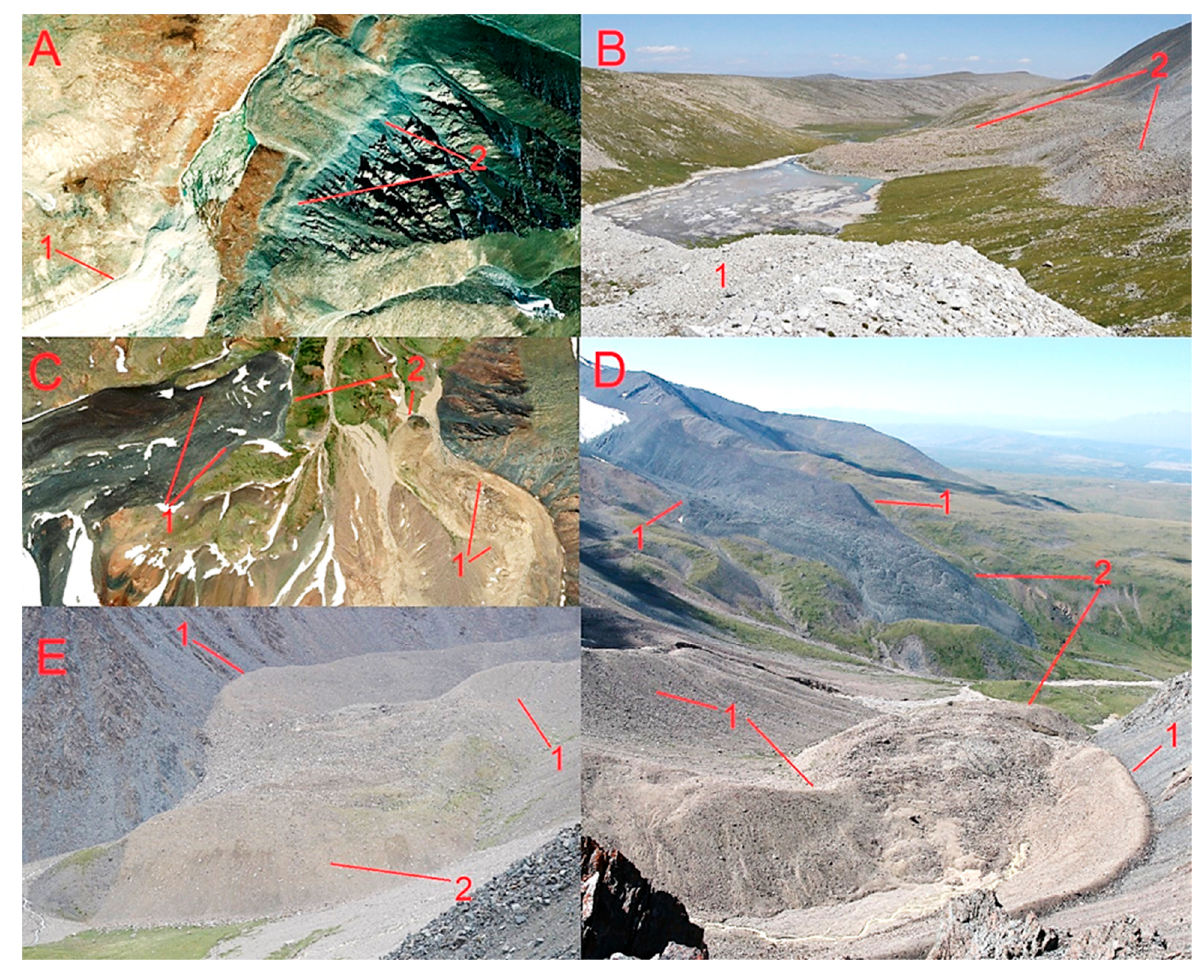
Figure 4. LIA moraines and rock glaciers. Tsengel Khairkhan ridge: ( A ) World View 2 image, 18 September 2011, ( B ) Photo, 31 July 2016: 1—LIA moraine, 2—Talus rock glacier. Mongun Taiga massif: ( C ) WorldView-2 image, 26 June 2015, ( D , E ) Photos 28 July 2008: 1—LIA moraines, 2—Debris rock glaciers.